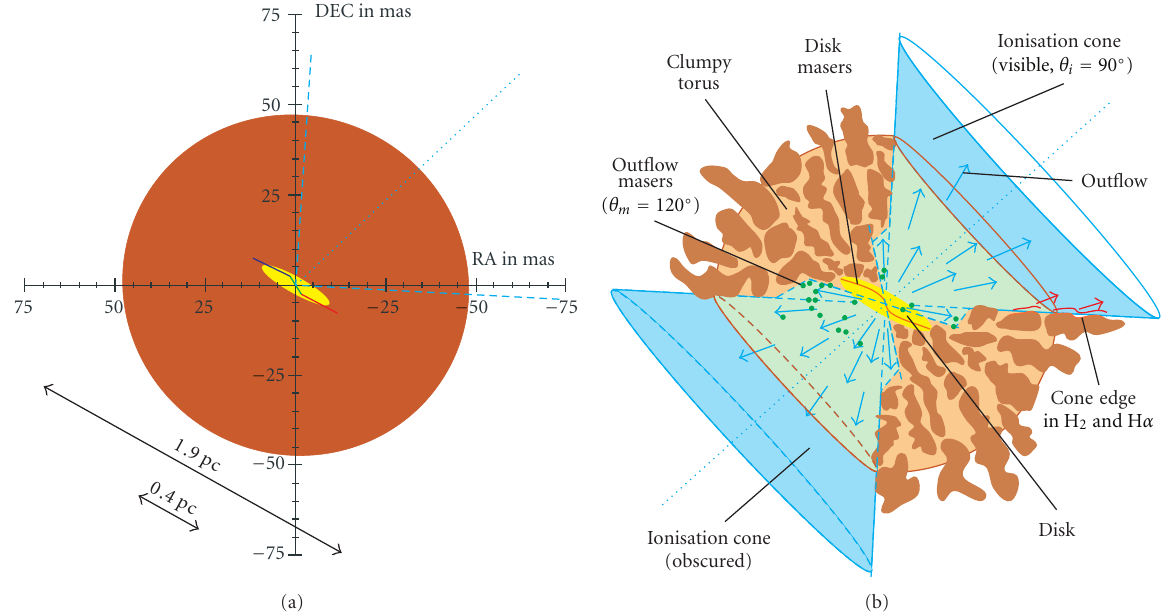
Figure 3: The Circinus Galaxy (from Tristram et al. [71]). (a): Sketch of the best-fit physical model where a warm ( T (cid:5) 330 K) emission region (yellow) is surrounded by a cooler ( T (cid:5) 300 K) one (brown). The water maser emitters are over-plotted (blue and red lines), together with the ionised cone (dashed and dotted light blue line). (b): the dusty torus as derived from the MIR interferometric observations.